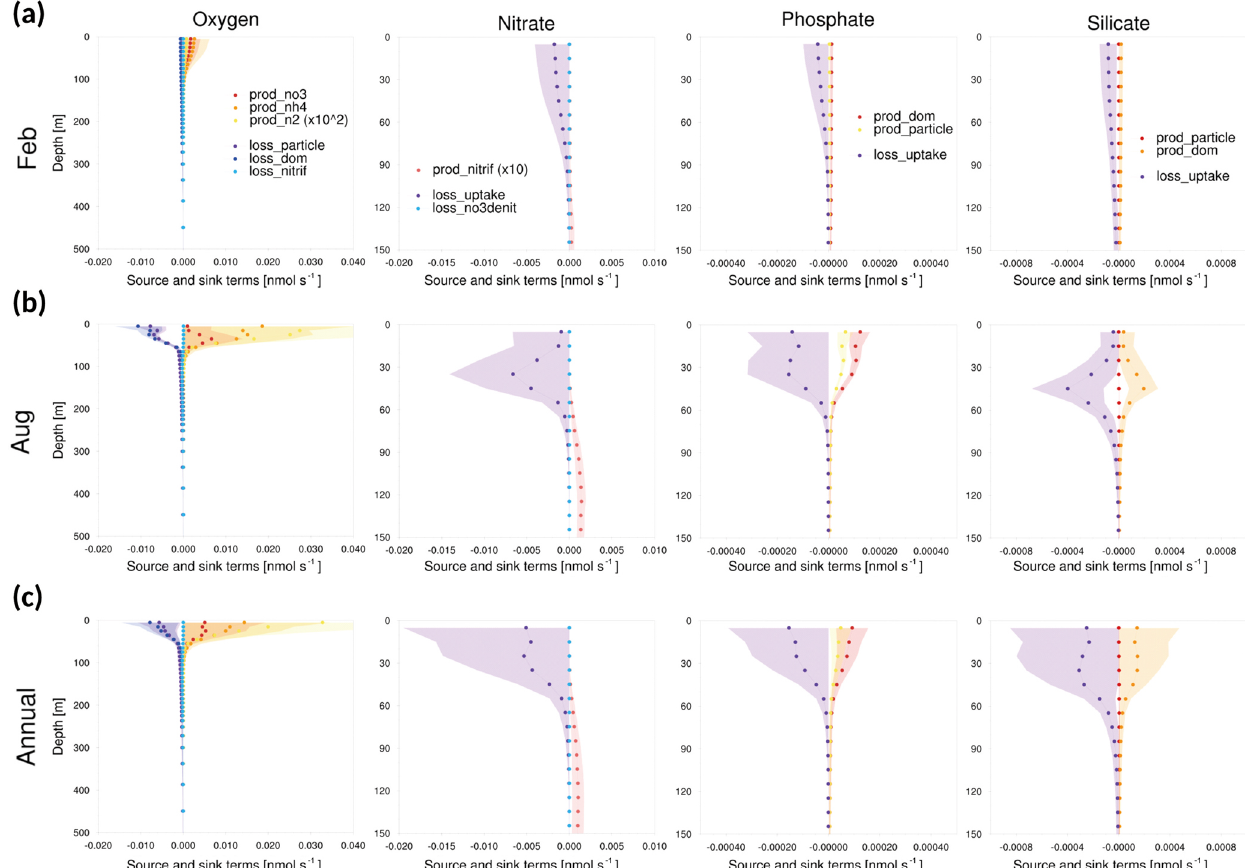
Figure 11. Vertical profiles of the tendencies of source and sink terms in GOTM–TOPAZ at point 107 for the 10-year period of 1999–2008, (a) for February, (b) for August, and (c) annually. The shaded areas represent 1 σ